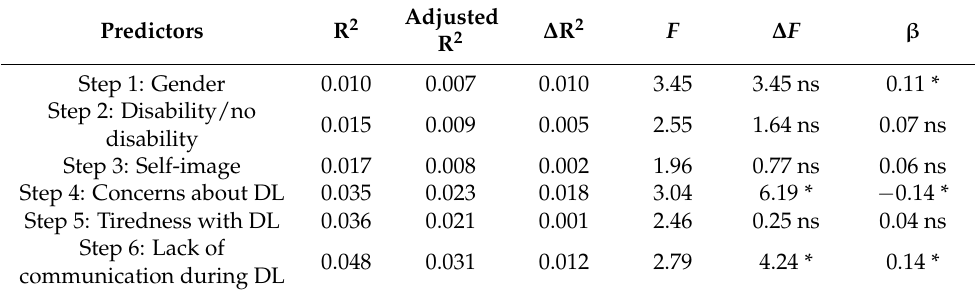
Table 4. Multiple regression analysis of demographics, self-image, concerns about distance learning, tiredness with distance learning, and lack of communication during distance learning on students’ e-attendance of theoretical